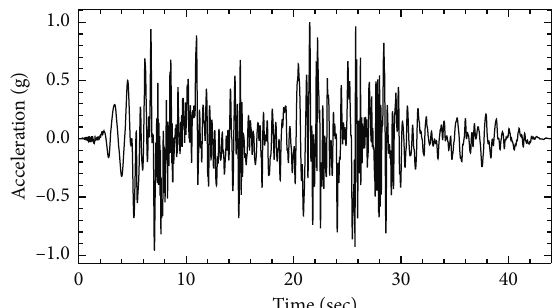
Figure 12: Artificial earthquake accelerogram.